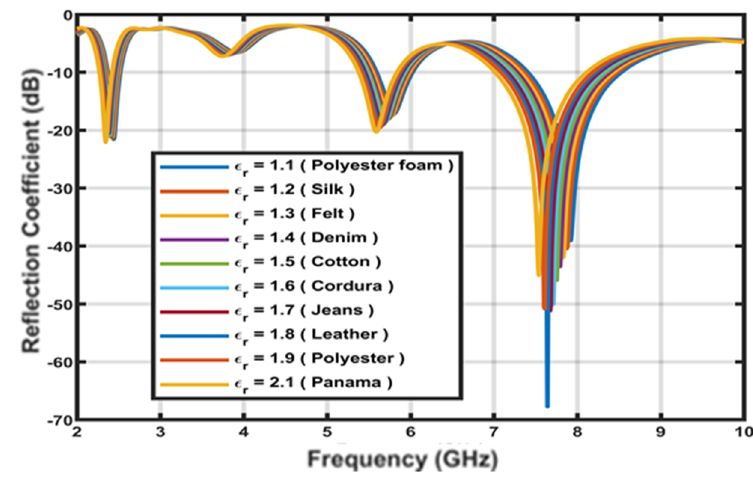
Figure 22. Reflection coefficient of the antenna for various undercover tests.